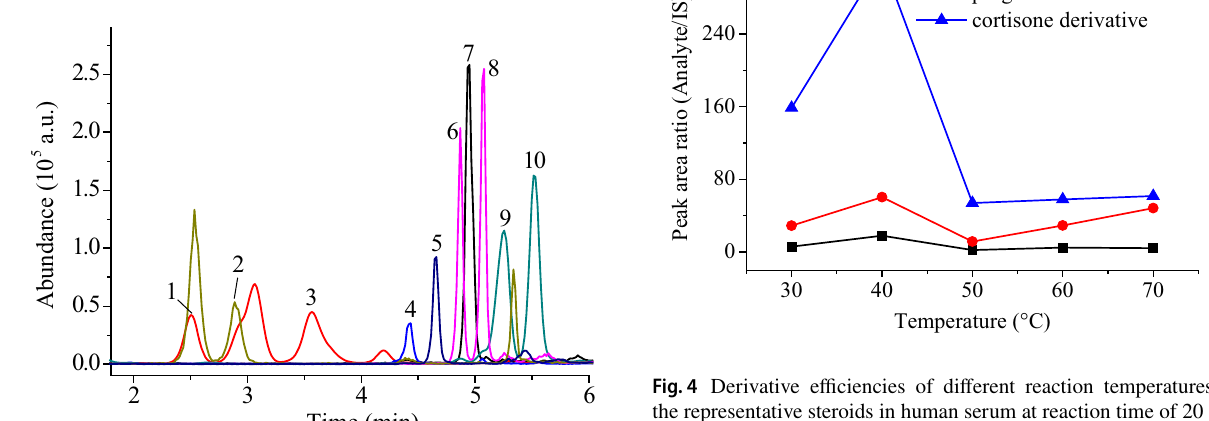
Fig. 1 The extracted ion chromatogram (EIC) of ten steroids with- out derivatization at the concentration of 500 ng mL −1 . 1—cortisone; 2—21-deoxycortisol; 3—corticosterone; 4—4-androstenedione; 5— dehydroepiandrosterone; 6—estrone; 7—testosterone; 8—dihydrotes- tosterone; 9—androsterone; 10—progesterone